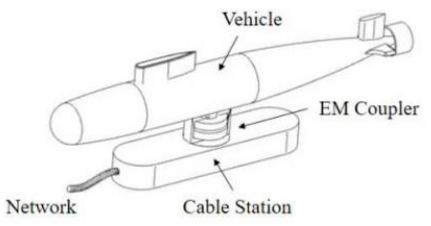
Figure 1. Underwater wireless power transfer system.